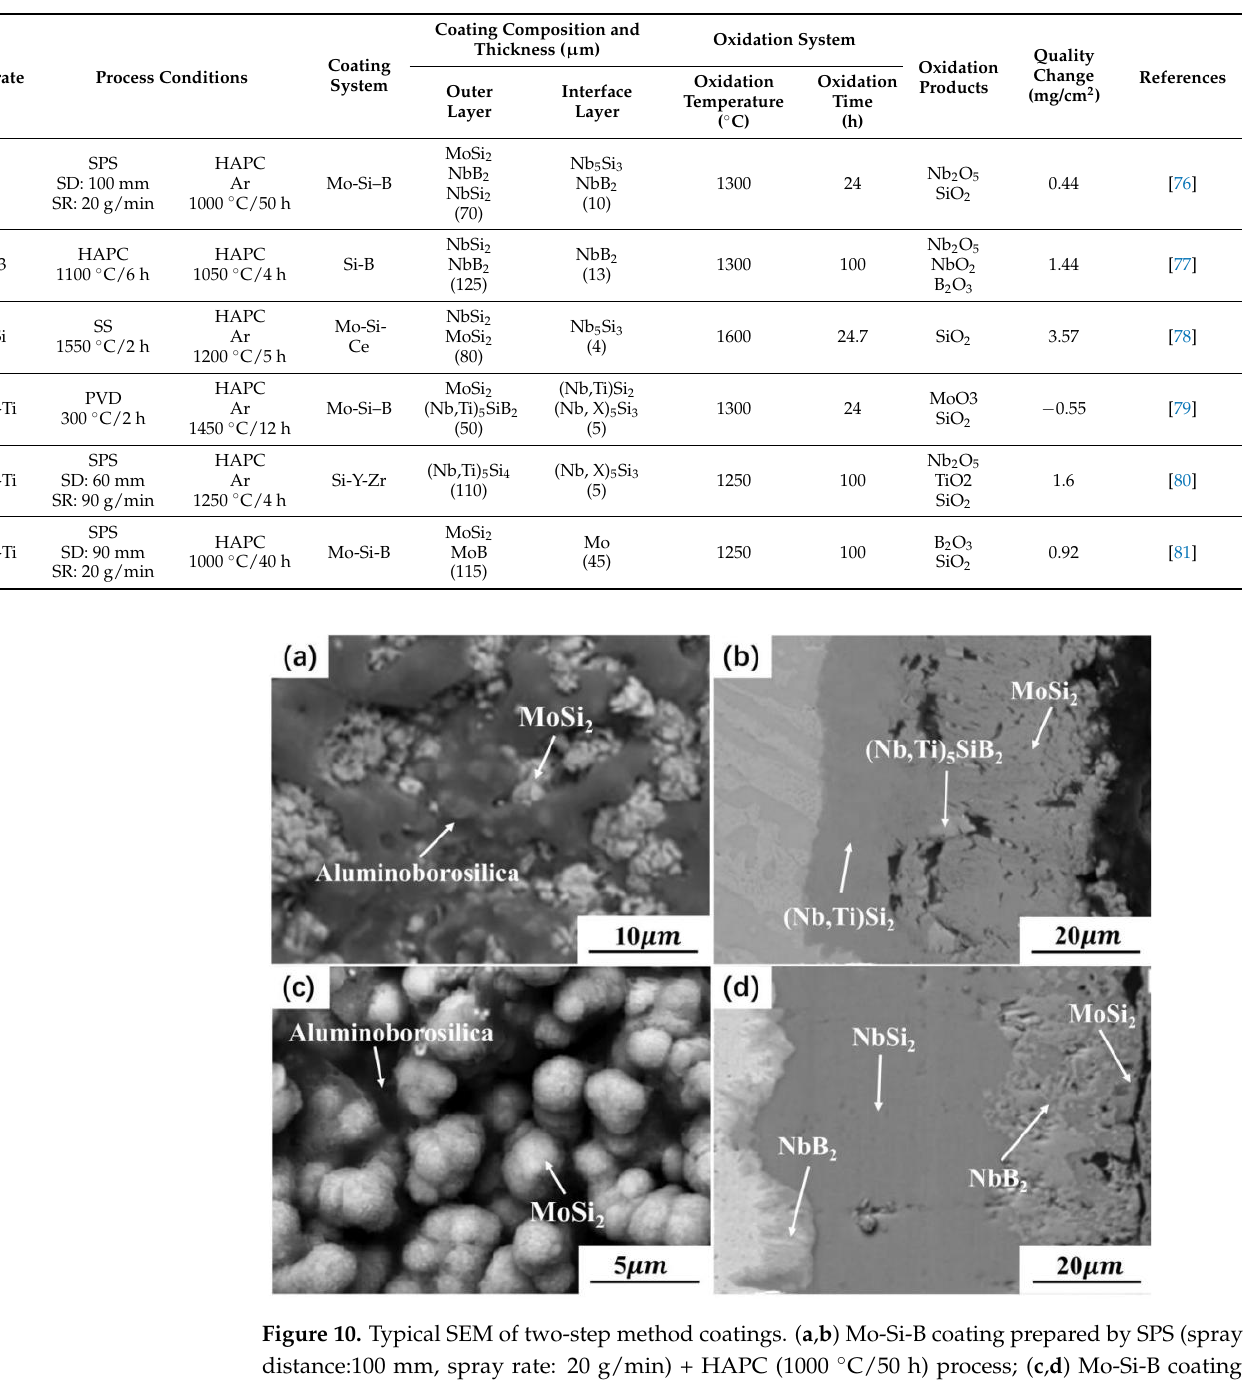
Table 4. Two-step coating preparation procedure and oxidation resistance details on Nb alloy surface.